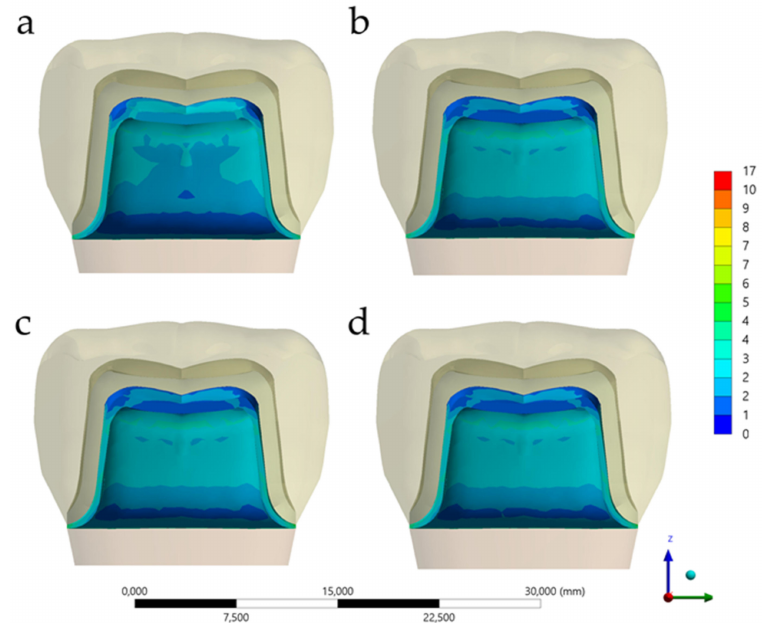
Figure 6. Stress distribution (MPa) in the cement layer according to PC material: ( a ) PEKK; ( b ) Tita- nium; ( c ) CoCr; and ( d ) Zirconia.